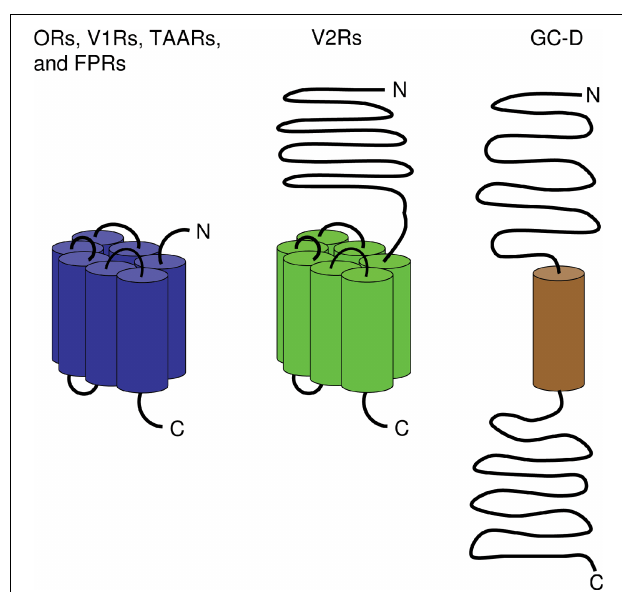
FIGURE 2 | Membrane topology of olfactory receptors. While ORs, V1Rs, V2Rs, TAARs, and FPRs belong to the GPCRs which encompass seven transmembrane domains (indicated by cylinders), guanylyl cyclase GC-D comprises only one transmembrane domain. In all these receptor types, the N-terminus is localized to the extracellular face of the cell membrane whereas the C-terminal end resides intracellularly. Unlike other olfactory receptors and similar to GC-D, V2Rs are endowed with a large N-terminal extracellular domain. In contrast to other olfactory receptors, GC-D also possesses a large C-terminal intracellular region. role in maintaining the structural integrity of the protein. Two of these (at positions 97 and 179) are common to all GPCRs and are believed to form a disulfi de link between extracellular loops 1 and 2; the other fi ve are unique to